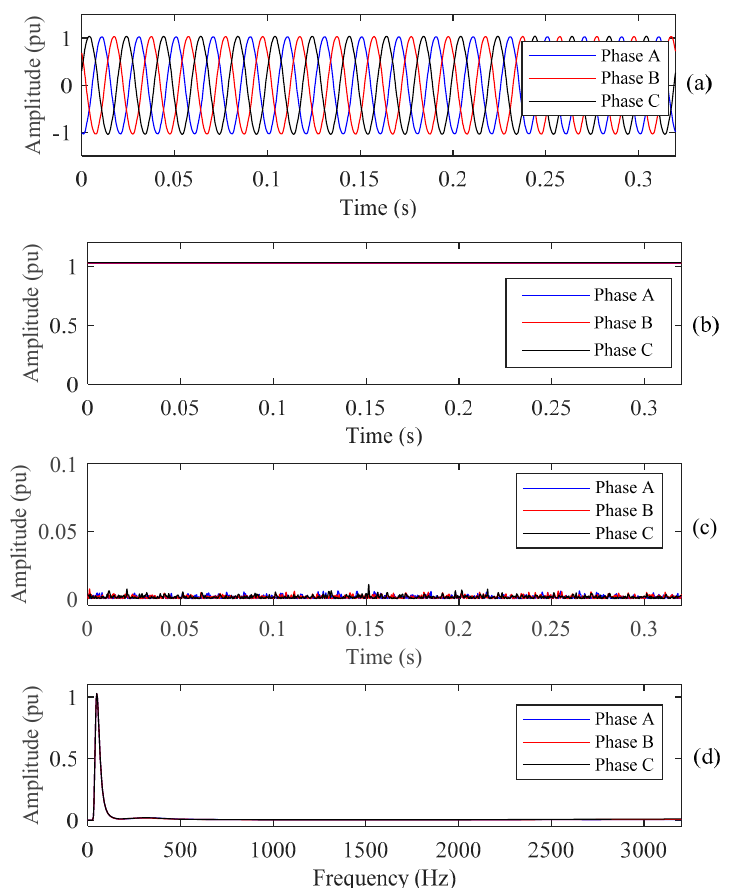
Figure 23. An actual voltage snapshot recorded by PQube at the University of Strathclyde on 29 June 2020 [45] and related STA : ( a ) three-phase voltage; ( b ) TvA ; ( c ) TvHFA ; ( d )